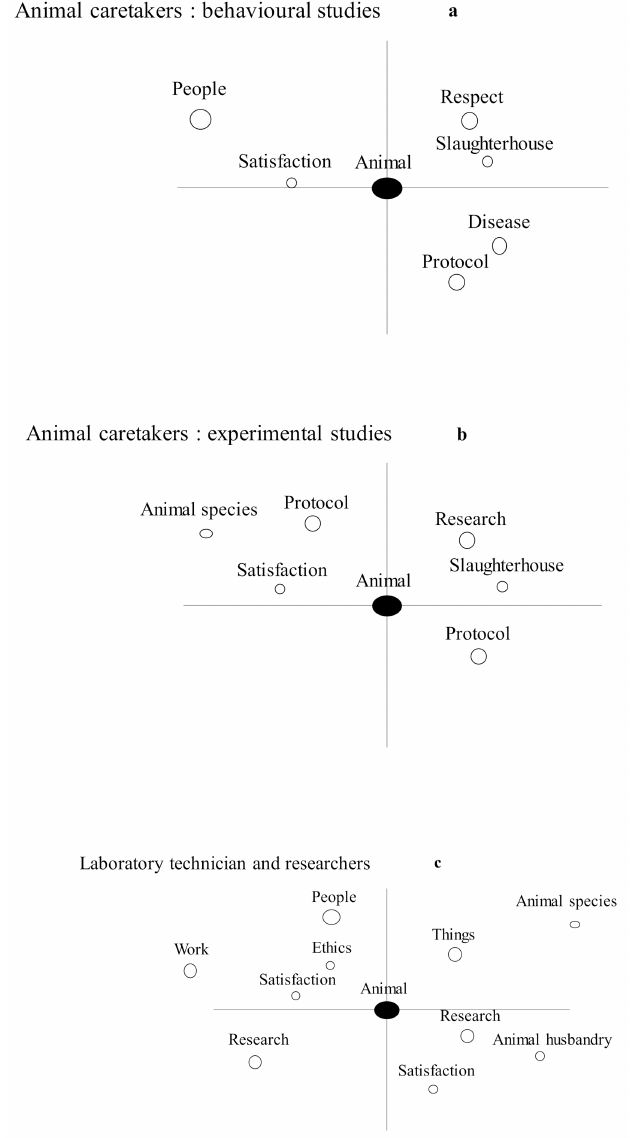
Figure 1. Multivariate analysis of interviews with: ( a ) animal caretakers involved in experimental studies; ( b ) caretakers involved in behavioral studies; and ( c ) laboratory technicians and researchers. The bubble size corresponds to the number of occurrences of the word; the distance between bubbles is smaller when the words are correlated; the left part of the graph corresponds to the beginning of interview and the right part to the end of